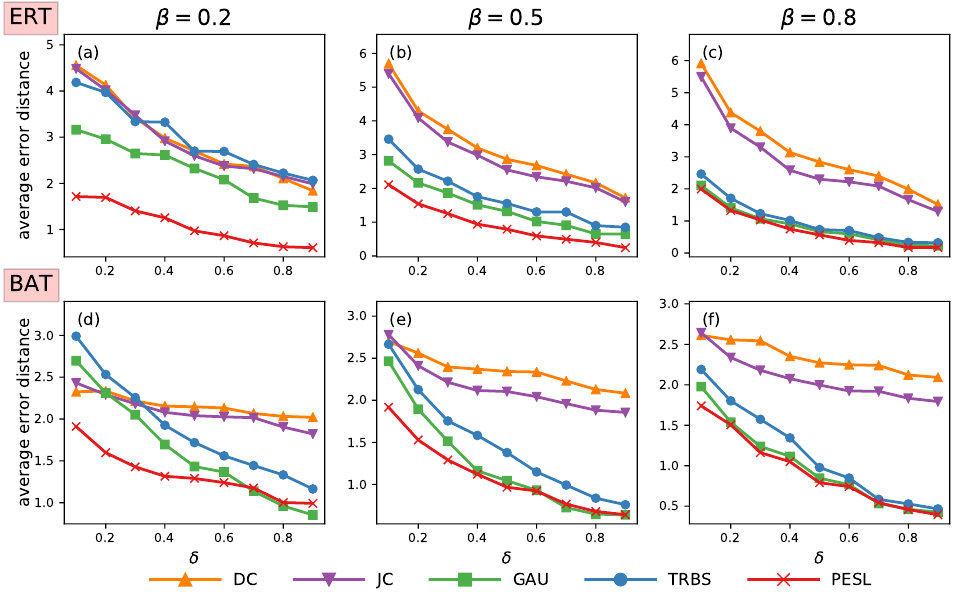
Figure 3. The relationship between epidemic source localization accuracy and reporting probability in tree networks. ( a – c ) represent the relationship between average error distance and reporting probability in ERT under the different infection probability of nodes β = 0.2,0.5,0.8 respectively. ( d – f ) represent the same results in BAT. The abscissa represents the reporting probability δ of